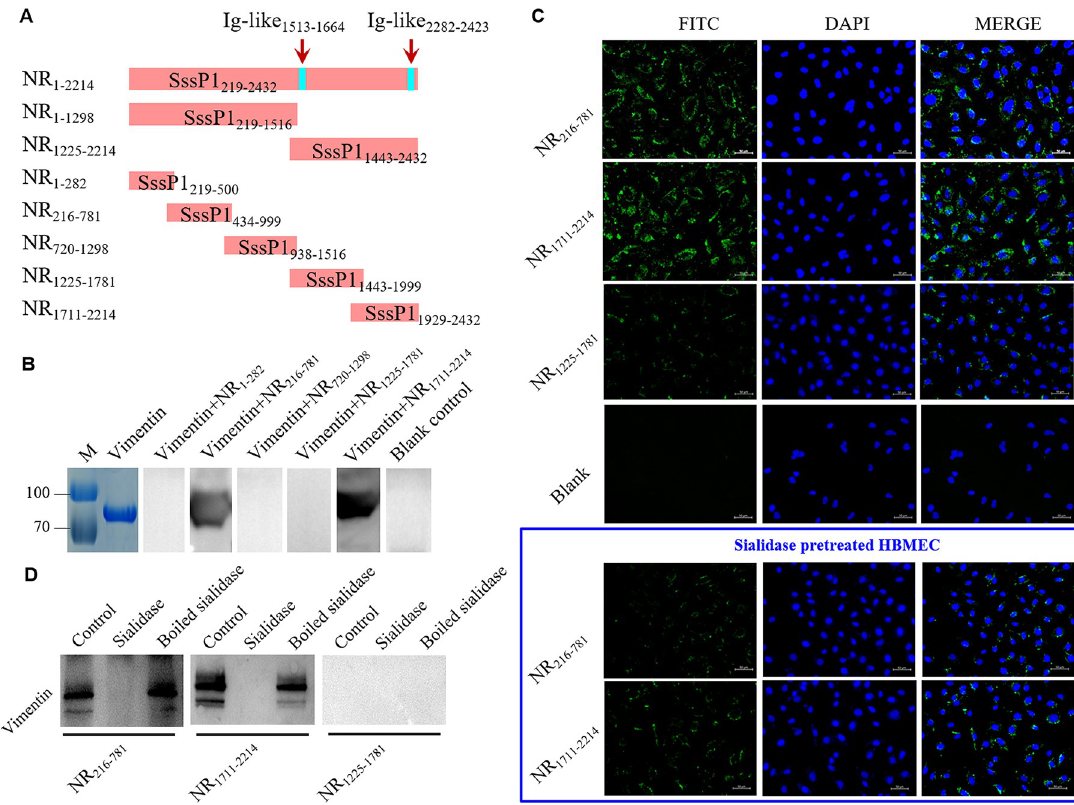
Fig 6. Identification of the smaller fragments required for SssP1 -NR2 attachment to vimentin. (A) Schematic diagram of the NR domain divided into 5 fragments according to the protein structure. (B) The Far-Western blot was performed to identify the interaction between vimentin and the indicated fragments of NR domain. (C) Contributions of the NR 216-781 and NR 1711-2214 fragments in bacterial adhesion to HBMECs. Several indicated cell samples were pretreated for 0.5 h at 37˚C using the sialidase (Sigma). The images show the DAPI-stained nuclei in blue, and the adhered proteins detected by goat anti-mouse IgG-FITC in green. The NR 1225-1781 was used as control. (D) The Far-Western blot analyses of NR domains using the sialidase (Sigma) pretreated vimentin (for 0.5 h at 37˚C). The hyaluronidase (Sigma) pretreated vimentin was used as